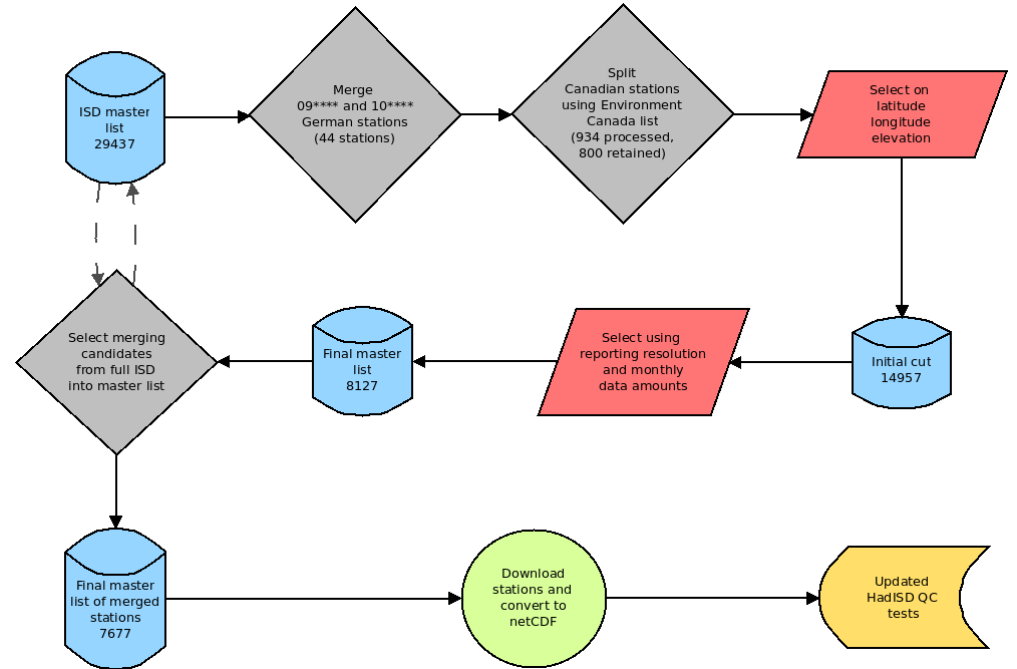
Figure 1. The process used for the station selection and merging in HadISD.2.0.0.